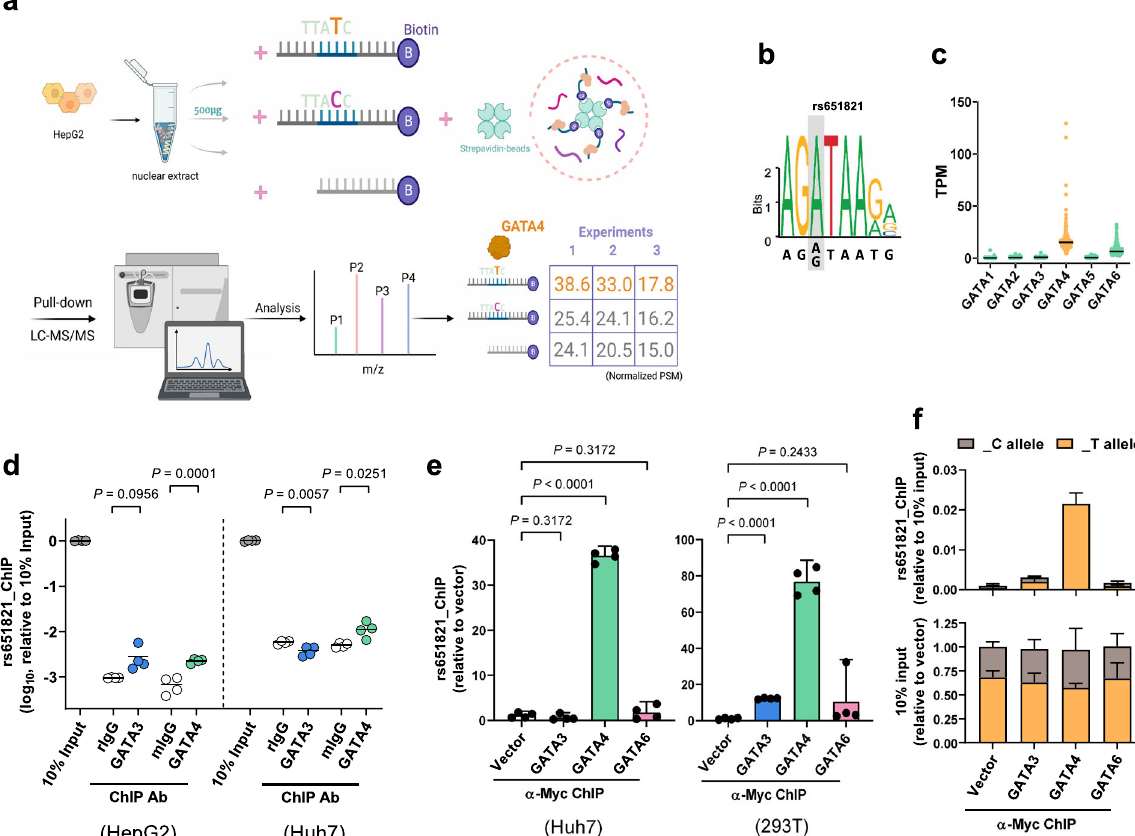
Fig. 3 Identi fi cation of transcription factors that preferentially bind rs651821. a Schematic diagram of the mass spectrometry screen for transcription factors that bind rs651821. Enriched peptides corresponding to GATA4 were normalized as indicated. PSM, peptide spectrum matches. The fi gure was created with BioRender.com. b GATA consensus motif retrieved from the JASPAR 2020 database (http://jaspar. genereg.net/). c Distribution and differential expression of individual members of the GATA family in GTEx liver tissues. d HepG2- and Huh7- cell DNA fragments after ChIP with normal rabbit IgG, normal mouse IgG, anti-GATA3, or anti-GATA4 were quanti fi ed by SYBR-based qPCR. e Histogram showing the relative rs651821 site enrichment after ChIP with anti-Myc using Huh7 or 293 T cells transfected with pXJ vectors expressing Myc-tagged GATA proteins. f DNA fragments before (lower panel) and after (upper panel) ChIP with anti-Myc performed in 293 T cells ( e ) were quanti fi ed by TaqMan-based qPCR for rs651821. The enriched speci fi c allele in each group was calculated and normalized by the respective FAM Δ Ct or VIC Δ Ct of 10% input, and the result is displayed by the addition of 2 – Δ Ct (FAM + VIC). P values and 95% CI (error bars) for the results within the fi gure are indicated; three independent experiments of n = 4 were